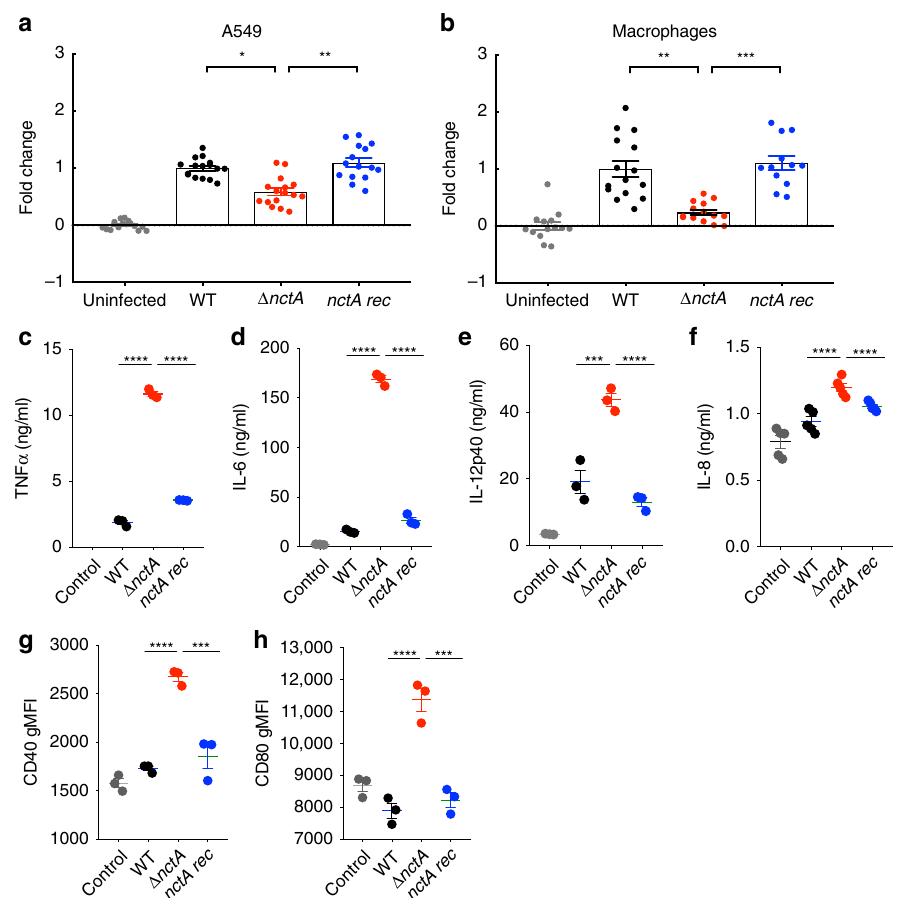
Fig. 7 Cytotoxicity and immunogenic properties of the nctA null mutant. a , b A549 epithelial cells or macrophages were infected with the wild-type (WT), the nctA null mutant ( Δ nctA ) or the nctA reconstituted isolate ( nctA rec ) for 24 h. Cytotoxicity of each mutant was evaluated by measuring the release of lactate dehydrogenase (LDH) activity into the culture medium. The data represent fi ve different infection challenges with triplicate LDH activity measurements. Data are shown in fold change of LDH activity relative to the wild-type-infected cells. The error bars mean the standard error of the mean (SEM), and P- values were calculated by Kruskal – Wallis test with Dunn ’ s correction: * P < 0.0180; ** P < 0.0056 (for a , A549 cells). ** P < 0.0032; *** P < 0.0007 (for b , macrophages). c – f Granulocyte macrophage colony-stimulating factor-induced bone marrow-derived dendritic cells (gm-csf BMDCs) were infected with the A. fumigatus strains with the multiplicity of infection (MOI) = 5:1. Proin fl ammatory cytokines were quanti fi ed by ELISA. Data represent three biological replicates ( c – e ) or fi ve biological replicates ( f ) with ± SEM. P- values were calculated by ANOVA with Tukey ’ s correction: *** P < 0.002; **** P < 0.0001. g , h Activation of dendritic cells measured by CD40 and CD80 markers by fl ow cytometry. Data represent three biological replicates with ±SEM. P -values were calculated by ANOVA: *** P < 0.0002; **** P < 0.0001 (for g ). *** P < 0.0004; **** P < 0.0001 (for h ). Source data are provided as